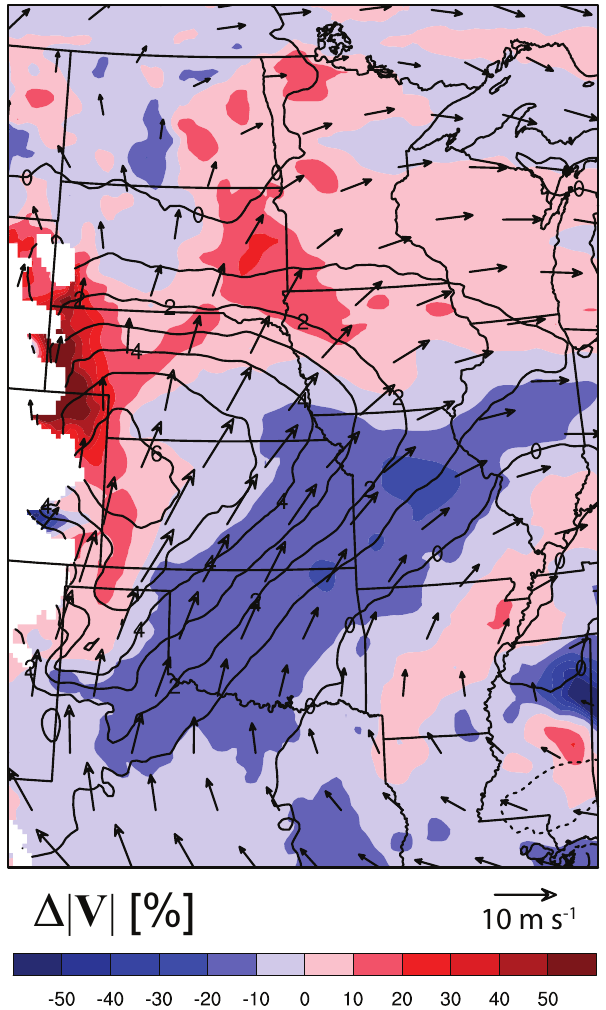
Figure 8. Composite of the mean July 850-mb simulation results, illustrating the differences in wind and geopotential height structure between the CTL and IRR simulations. Vectors represent the 850-mb mean wind for the IRR simulation. The dark black contours indicate the mean difference in 850-mb geopotential height (IRR–CTL). The contour interval is 1 m, with negative contours dashed. The color-shaded contours represent percent difference in IRR mean wind speed with respect to the CTL simulation. Red indicates the IRR flow is faster than the CTL flow; blue indicates the IRR flow is slower than the CTL